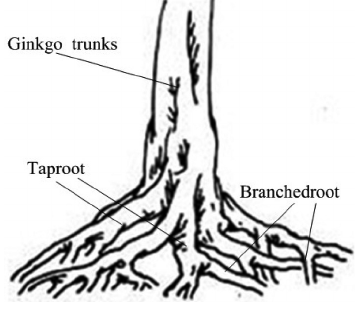
Fig. 1. Ginkgo root system